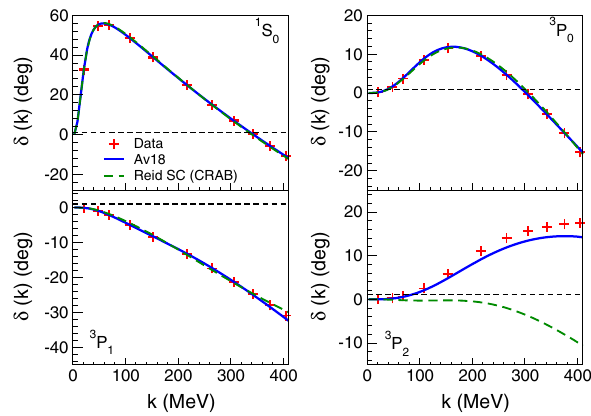
Fig. 2 Phase shifts as a function of the relative momentum k for the p–p system using the Argonne v 18 potential (blue solid line) and the Reid SC potential as used in CRAB calculations (green dashed line). The phase shifts are taken from